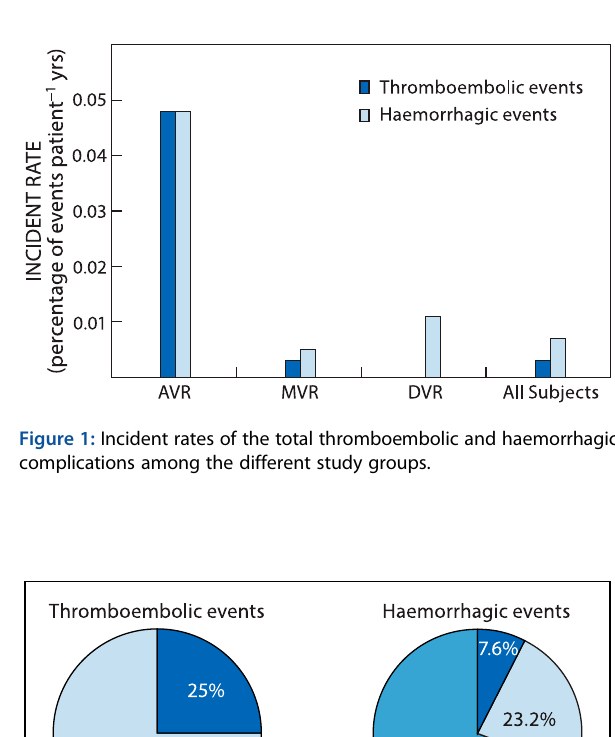
Clinical co- morbidities